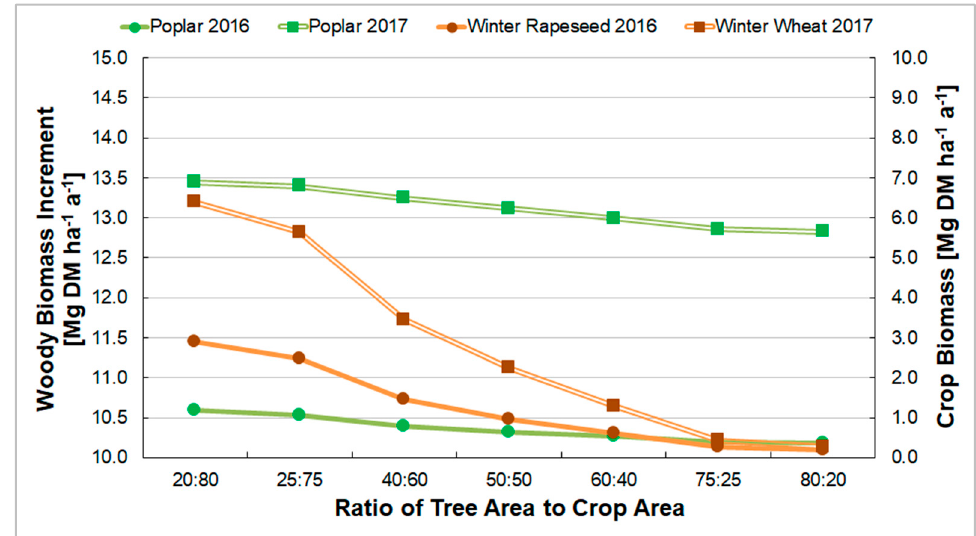
Figure 5. Above-ground tree woody biomass and crop yields, as simulated by the Yield-SAFE model at Wendhausen, under different ratios of tree area to crop area.